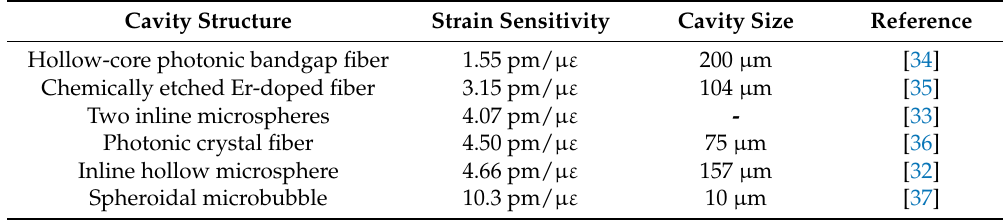
Table 1. Strain sensitivity comparison between different cavity